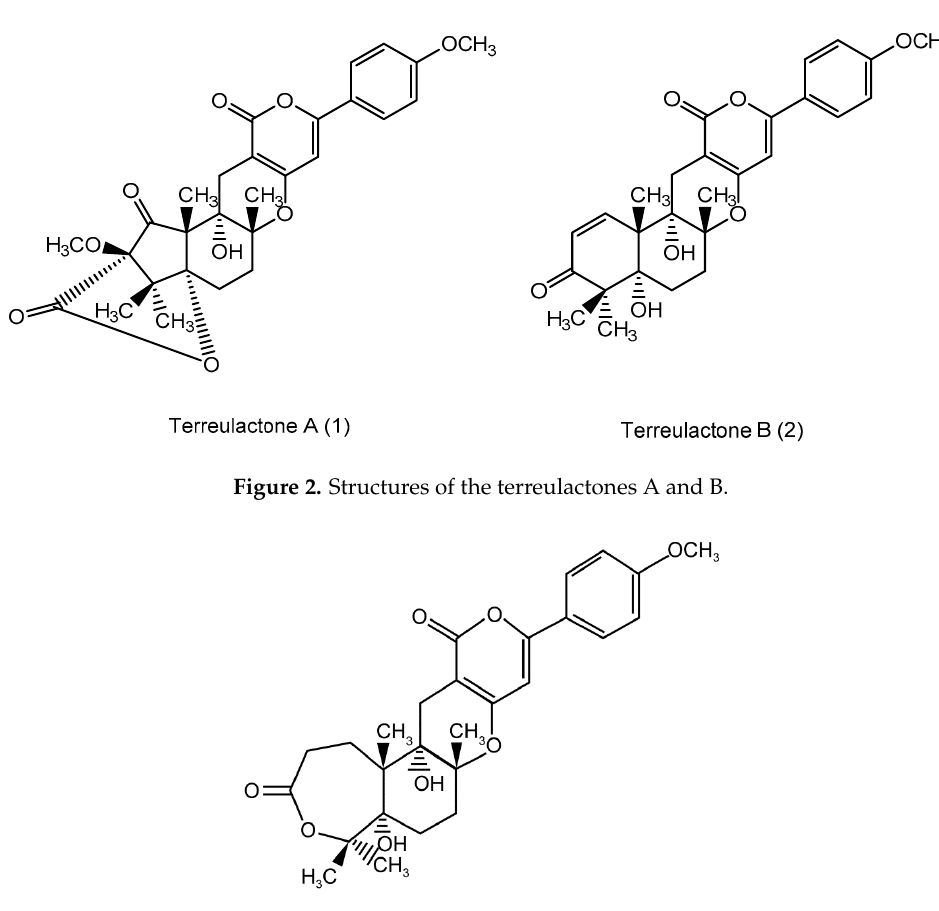
Figure 3. Structure of isoterreulactone A.